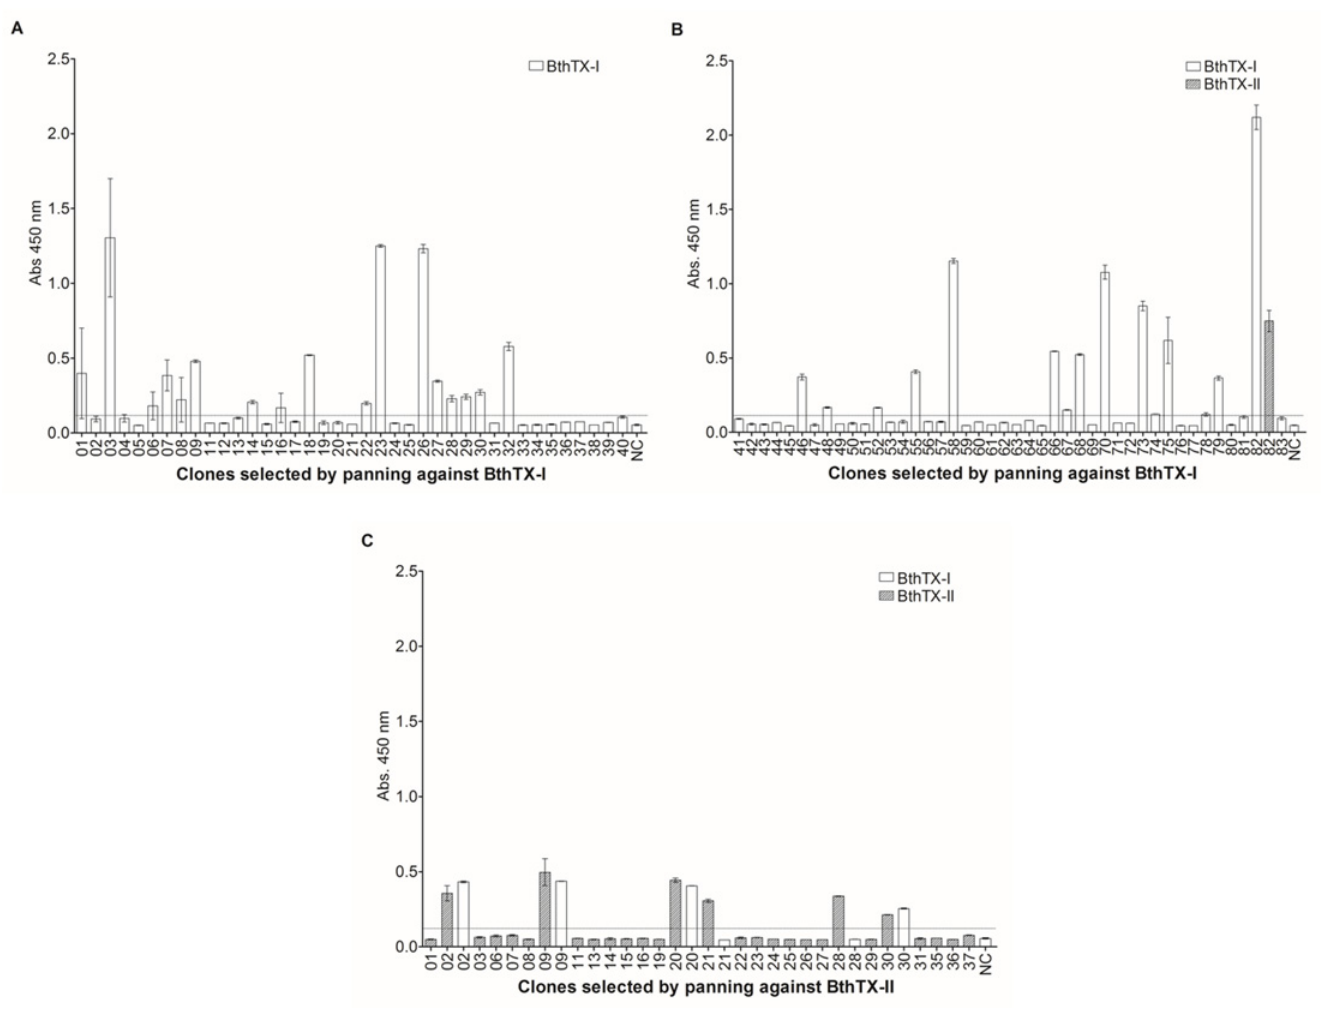
Fig 1. Selection of anti-BthTX-I and anti-BthTX-II VHHs. VHHs from the recombinant phage displayed library were submitted separately against immobilized BthTX-I or BthTX-II. After one round of panning, 82 and 28 clones selected for BthTX-I and BthTX-II, respectively, presented VHHs. ELISA assays were performed to verify clone reactivity. Twenty-eight (28) and six (06) clones recognized BthTX-I and BthTX-II. (A) Clonal reactivity of VHHs (1 – 40) selected against BthTX-I, NC – negative control; (B) Clonal reactivity of VHHs (41 – 83) selected against BthTX-I, Cross-reactivity of VHH 82 with BthTX-II, NC – negative control; (C) Clonal reactivity of VHHs (1 – 37) selected against BthTX-II, Cross-reactivity of 02, 09, 20, 21, 28 and 30 VHHs with BthTX-I, NC – negative control. All clones that showed an absorbance value (OD 450nm) higher than the stipulated cut-off point (2 mean OD from negative samples plus 2 standard deviations) were considered positive. All measurements were performed in triplicate. The negative control was performed using the llama pre- immune serum. Error bars represent standard